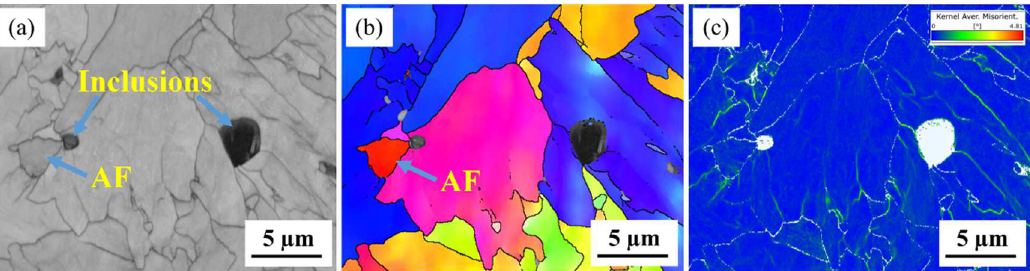
Figure 4. EBSD characterization of the same area containing complex inclusions. ( a ) IQ map, ( b ) IPF map and ( c ) KAM